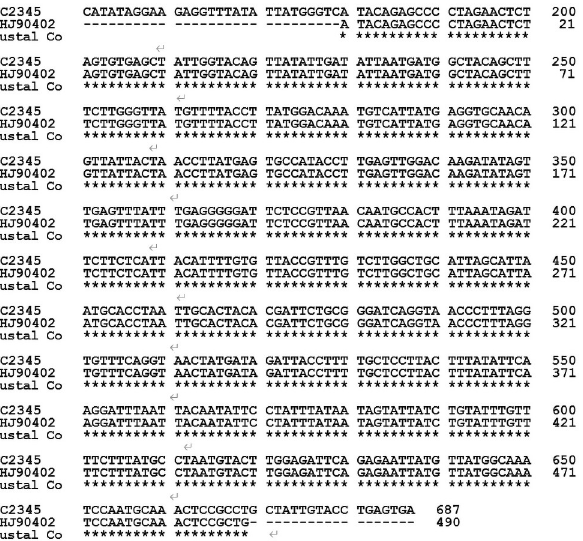
Fig 5. An alignment of the Cytb gene sequences compared with similar gene from other fungi. MCC2345: Lasiodiplodia theobromae isolate from papaya (GenBank: MH880818.1). YZHJ90402: pyraclostrobin resistance isolate of L. theobromae from mango.